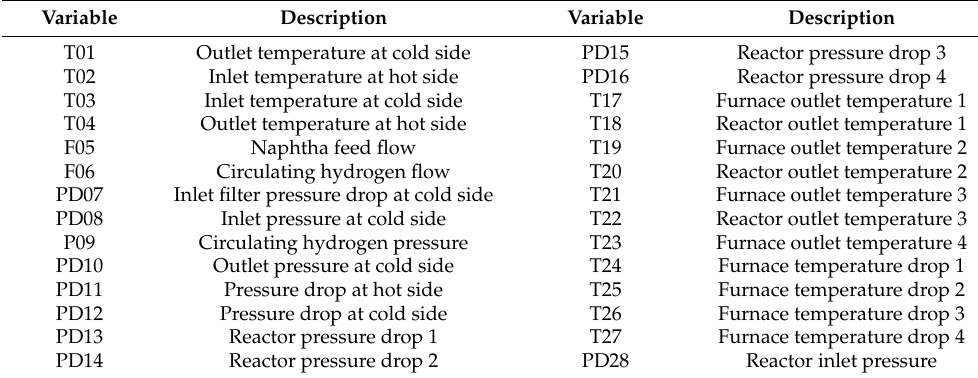
Table 4. Process variables in the continuous catalytic reforming unit.